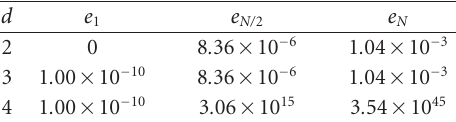
Table 6.12. Approximate error for Example